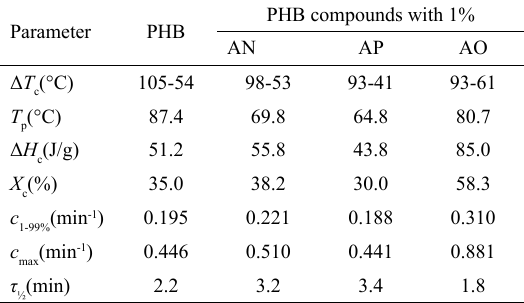
Table 3. Selected crystallization parameters, PHB and PHB/ Bentonite compounds. Parameter